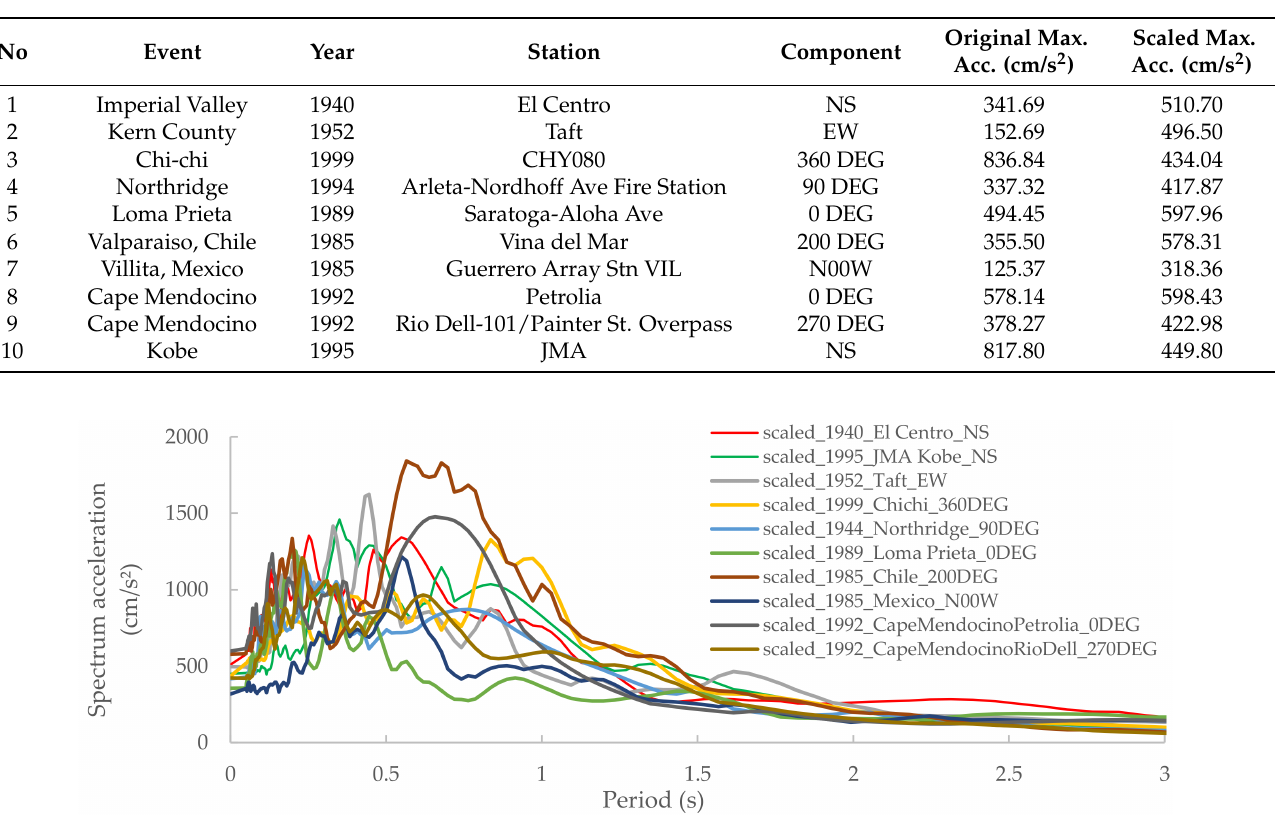
Figure 15. 2D plan of generated structure of 2 × 5 bays for 6-story building. Nonlinear dynamic analyses were performed using STERA_3D, and the story damage indices were populated. The list of input earthquake ground motions is shown in Table 5. Ten input ground motions are recorded acceleration waves scaled to have the maximum velocity of 50 cm/s. The ground motion data are retrieved from PEER [26] and COSMOS Virtual Data Center [27]. The intensity of these input ground motions corresponds to the level of design earthquakes for the safety limit state in the Japanese seismic standard. The acceleration response spectrum is presented in Figure 16, and the wave shapes of the earthquake input motions are depicted in Figure 17. Table 5. Selected earthquake ground motion.